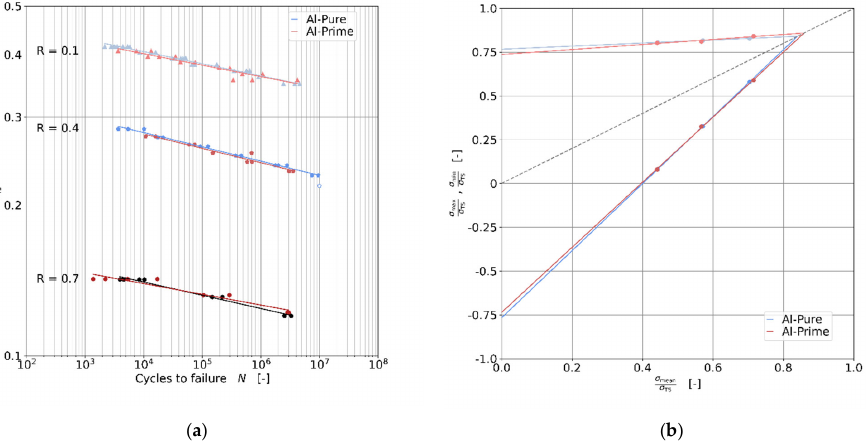
Figure 7. Wöhler diagram scaled to the tensile strength σ TS of each wire material ( a ), Smith diagram scaled to tensile strength σ TS of each wire material ( b ).